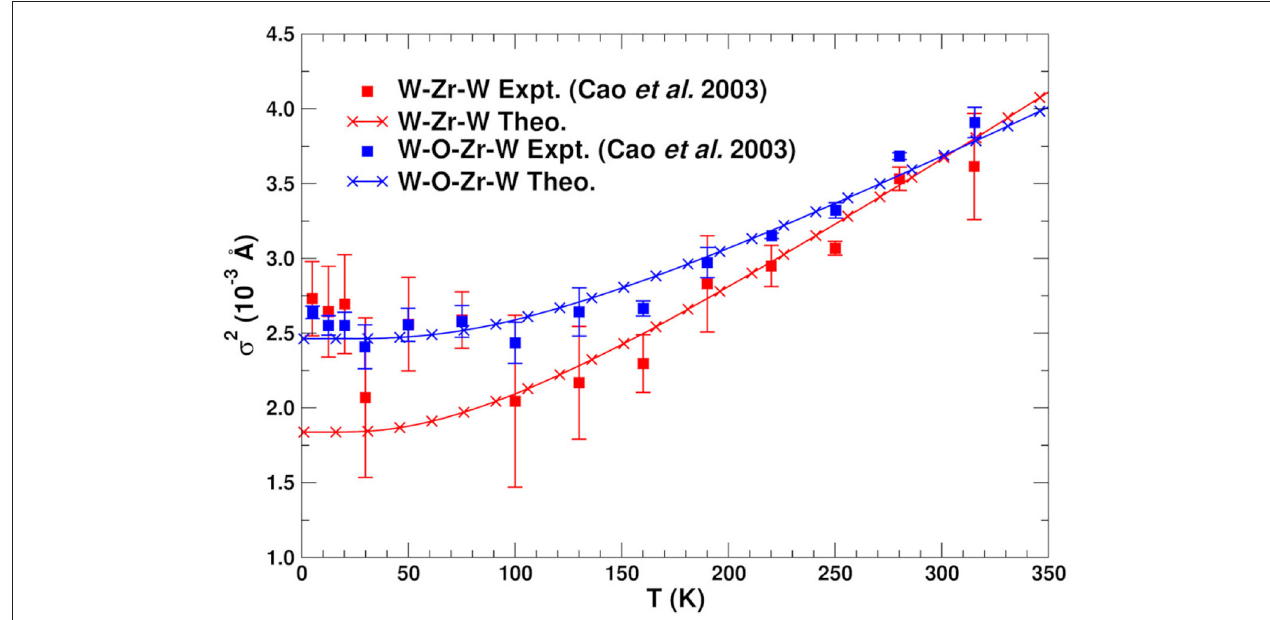
FIGURE 4 | Comparison of the experimental (Cao et al., 2003) and theoretical MSRD σ 2 for the SS and MS paths associated with the Zr–W linkage in ZrW 2 O 8 . The theoretical values are shifted vertically to account for experimental static disorder.